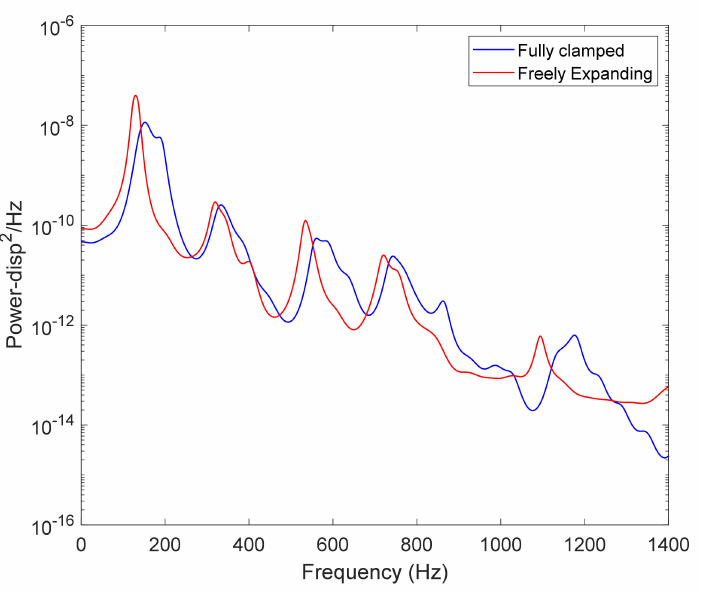
Figure 8. Power spectral densities of the transverse responses of the panel center predicted by Nastran for the freely expanding plate and its fully clamped counterpart under an excitation of OASPL = 147